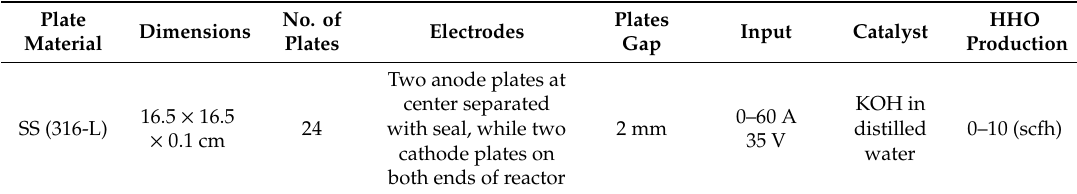
Table 2. HHO Unit